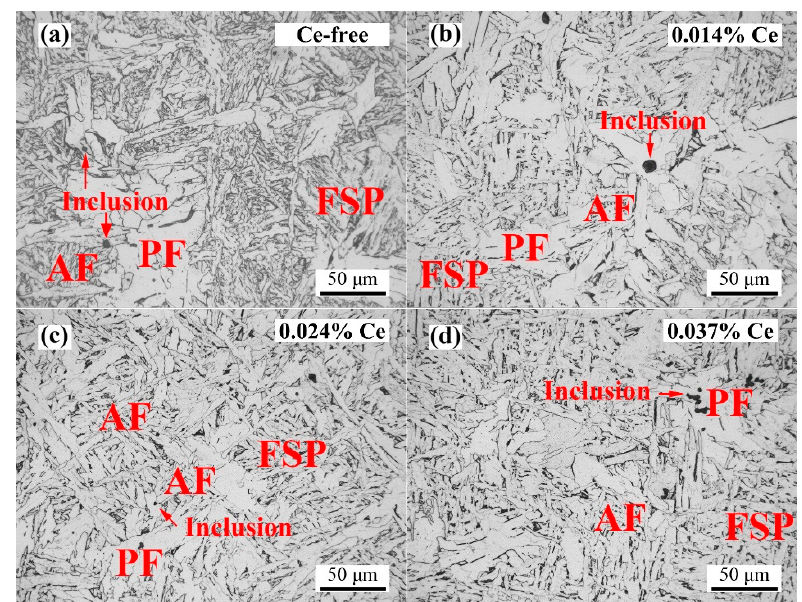
Figure 8. Microstructure of tested steels. ( a ) #1; ( b ) #2; ( c ) #3 and ( d ) #4.